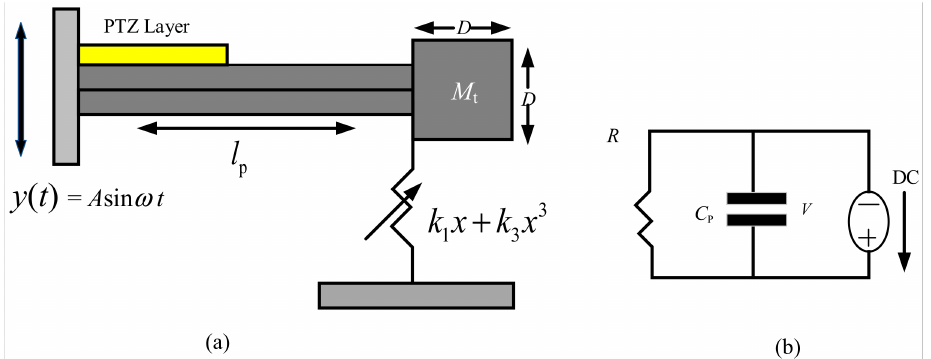
Figure 17. ( a ) Schematic of the energy harvester. ( b ) Simplified electrical circuit